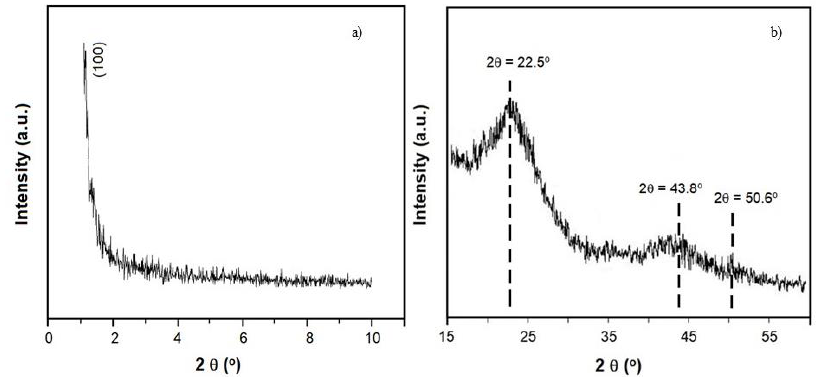
Figure 1. X-ray di ff ractograms of the bimodal silica at a low angle ( a ) and a high angle ( b ). Figure 1. X-ray diffractograms of the bimodal silica at a low angle ( a ) and a high angle ( b ).